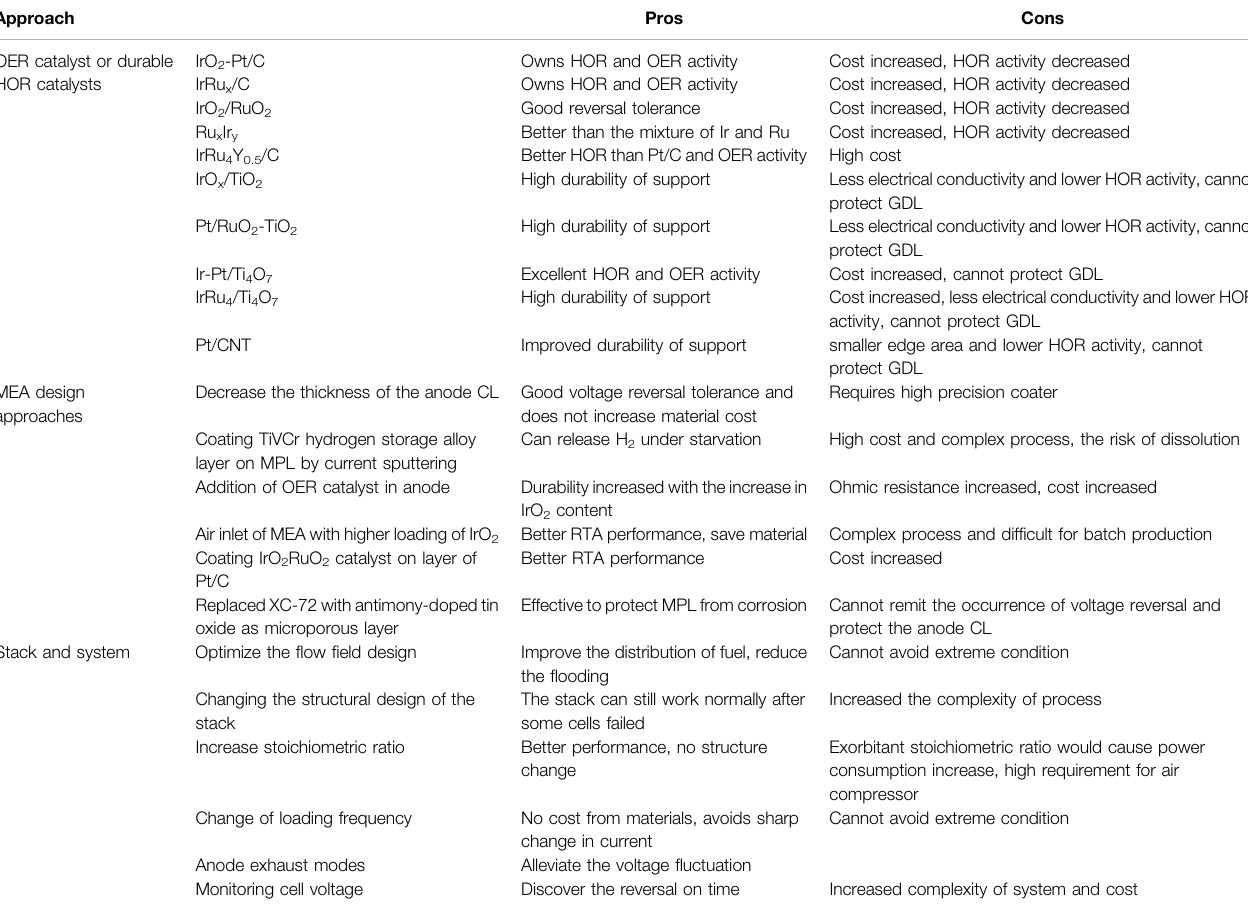
TABLE 1 | Pros and cons of different approaches for mitigating voltage reversal.